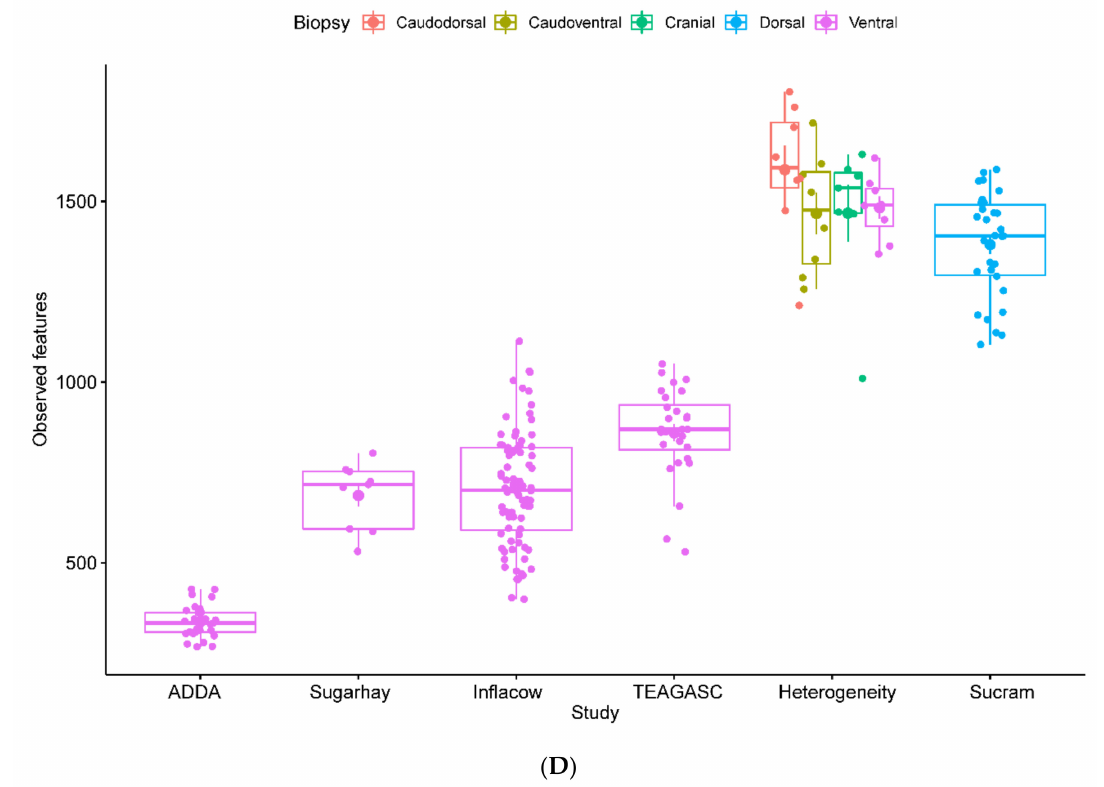
Figure 8. Faith phylogenetic diversity and richness estimator observed features measurements according to hypervariable region ( A , B ) and biopsy location ( C , D ),